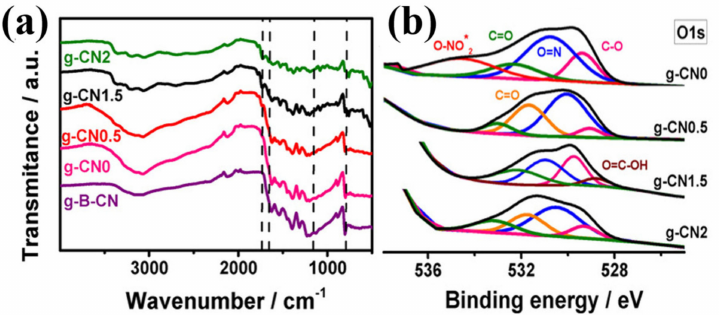
Figure 14. ( a ) The surface oxygen functional group of g-C 3 N 4 nanorods can be evidenced by the appearance of the peak at 1780cm − 1 which is due to the stretching and bending vibrations of carbonyl and carboxyl groups. ( b ) The high-resolution XPS spectra of O-1s with its deconvolution clearly reveal the presence of C=O and C − O. Reproduced with permission from [277]. John Wiley and Sons,